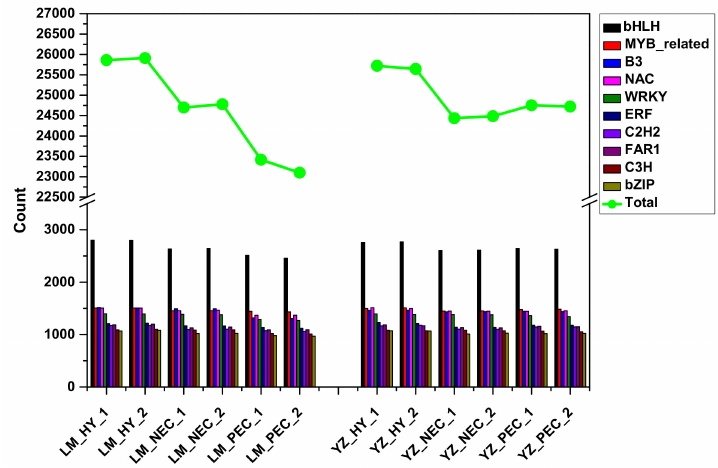
Figure 4. Transcription factors involved in di ff erent developmental stages during cotton SE in the two